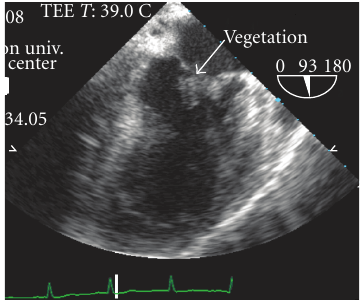
Figure 1: Transesophageal echocardiogram revealing vegetation on the mitral valve leaflets.